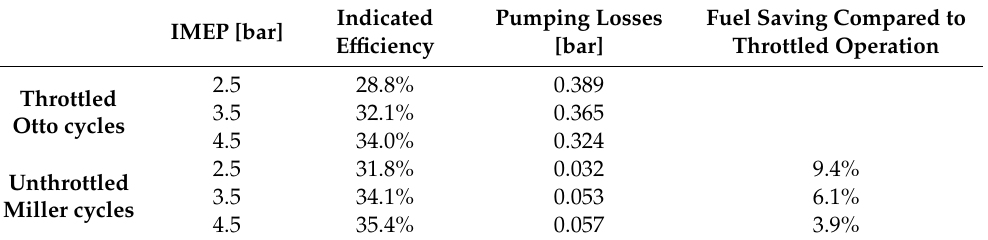
Table 4. Comparison between throttled and unthrottled operation.